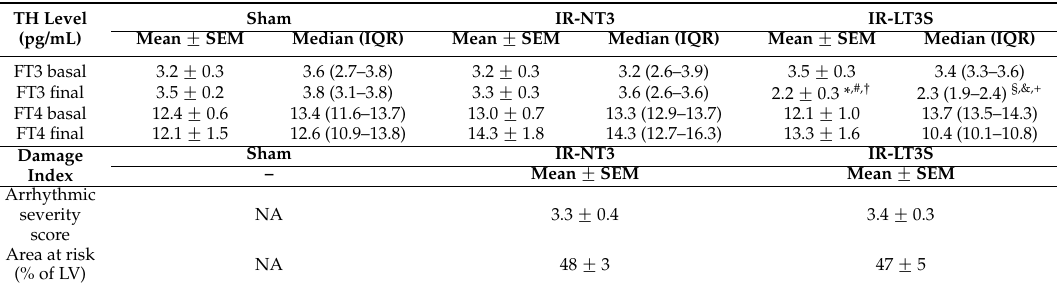
Table 1. Serum free thyroid hormone and LV damage index.